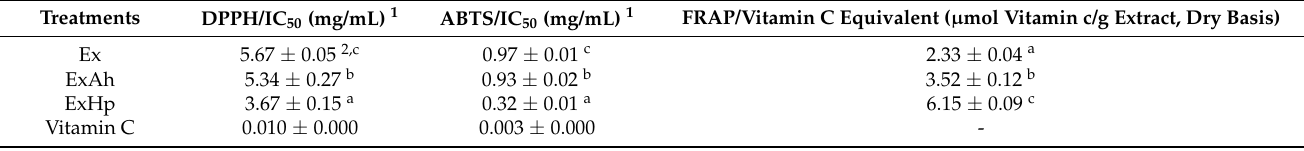
Table 5. Antioxidant activities of Ex, ExAh, and